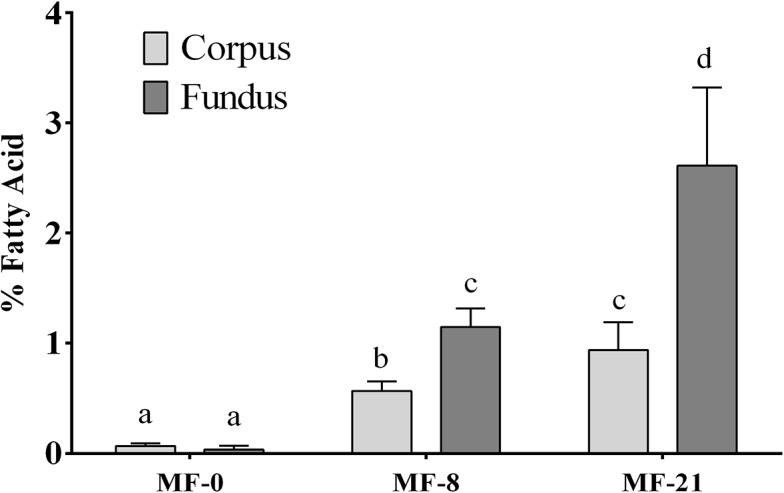
Effect of dietary tricaprylin level on C8:0 availability in the stomach tissue in the MF groups.The stomach tissue was dissected and the fatty acids of the fundus and corpus were analyzed. The C8:0 available in the different parts of the stomach is expressed as mean ± SEM in % of FAs in the tissues. The effect of the diet and the localization in the stomach tissue was analyzed using two-way ANOVA: (i) effect of the diet on C8:0 availability, P<0.0001; (ii) effect of the part of the stomach tissue studied on C8:0 availability, P = 0.0092; (iii) interaction between the two factors, P = 0.0387.